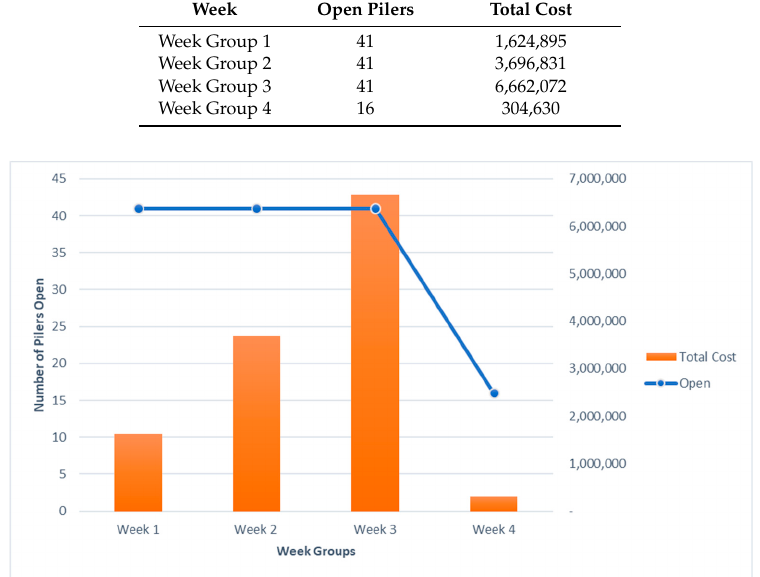
Table 2. Optimization Results.